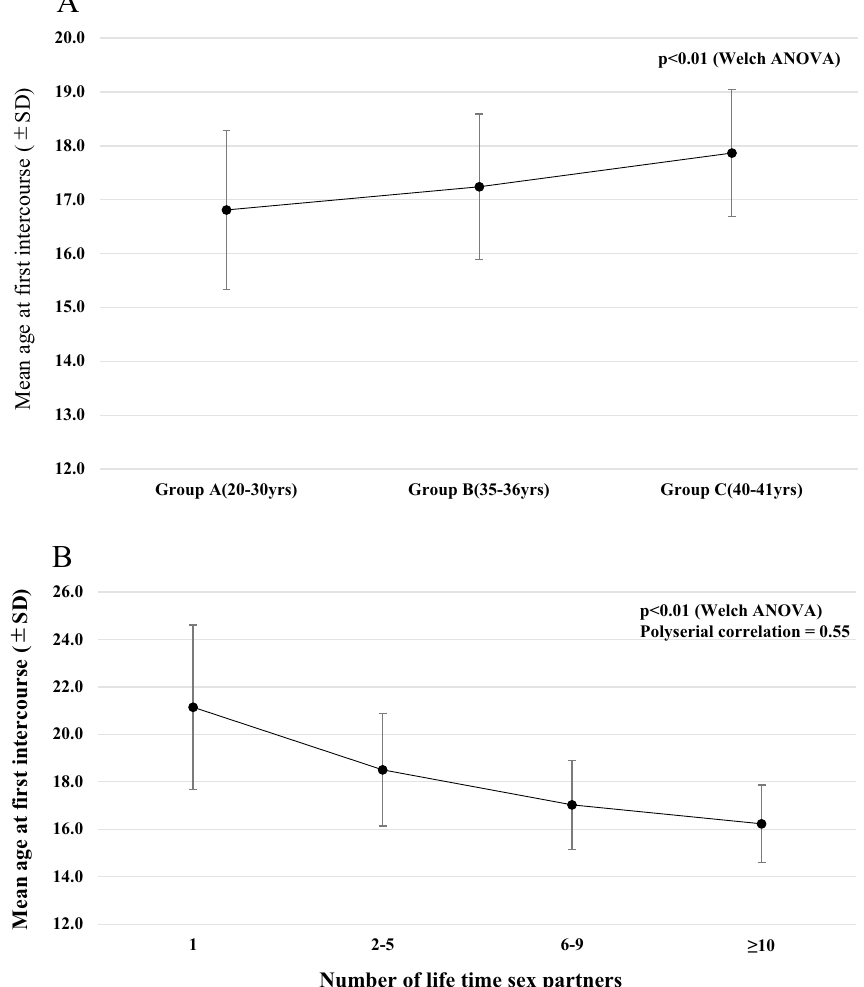
Figure 1. ( A ) Comparison between age-groups of mean age at sexual debut in women who first had sex as a teenage (n = 2329) Mean age at first intercourse was significantly earlier in group A (16.8 ± 1.5), compared to groups B (17.2 ± 1.4) and C (17.9 ± 1.2) ( p < 0.01). ( B ) Correlation between multiple number of lifetime sexual partners and lower age at first intercourse (n = 3231). There was a significant correlation between lifetime number of sexual partners and lower age at first intercourse ( p < 0.01, polyserial correlation =